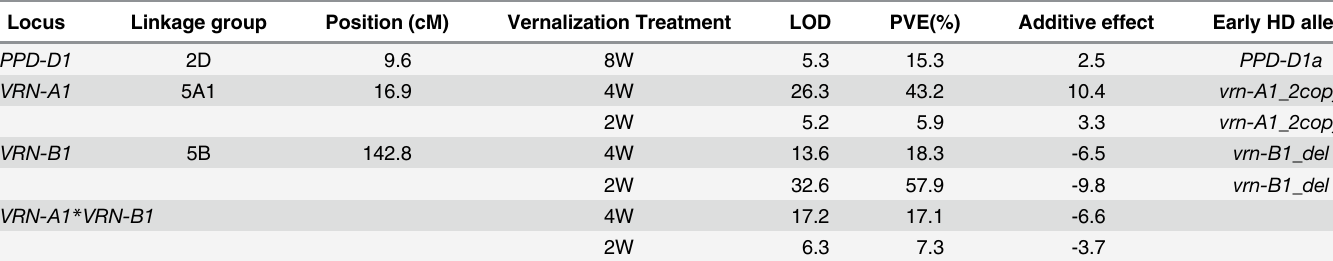
Table 2. Major QTLs for heading date in the greenhouse experiment.